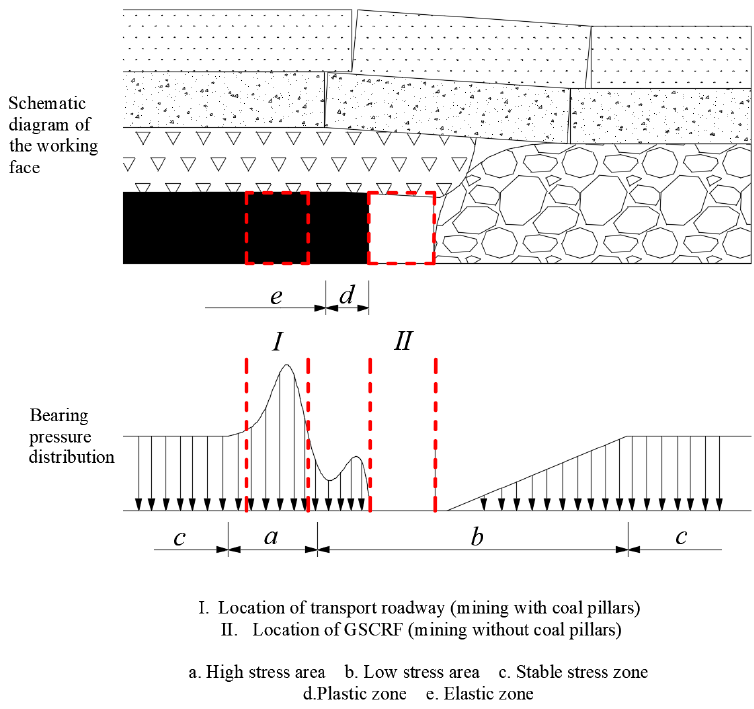
Figure 2. Bearing pressure distribution diagram of working face.